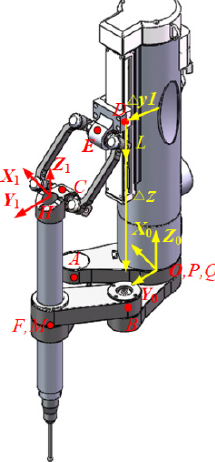
Figure 6. Coordinate system of kinematic model.